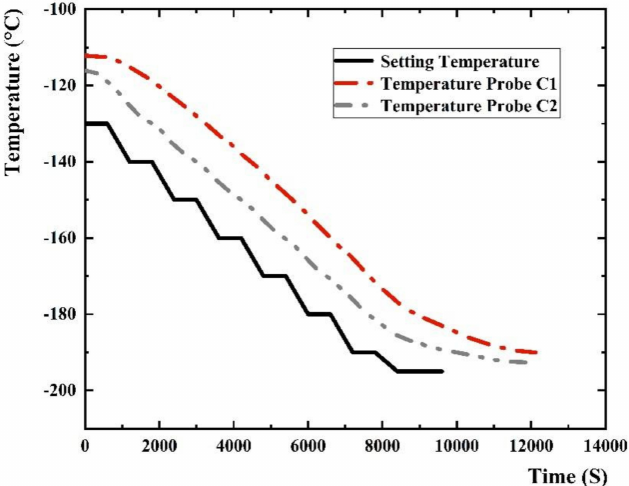
Figure 2. The temperature control and cooling curve of the